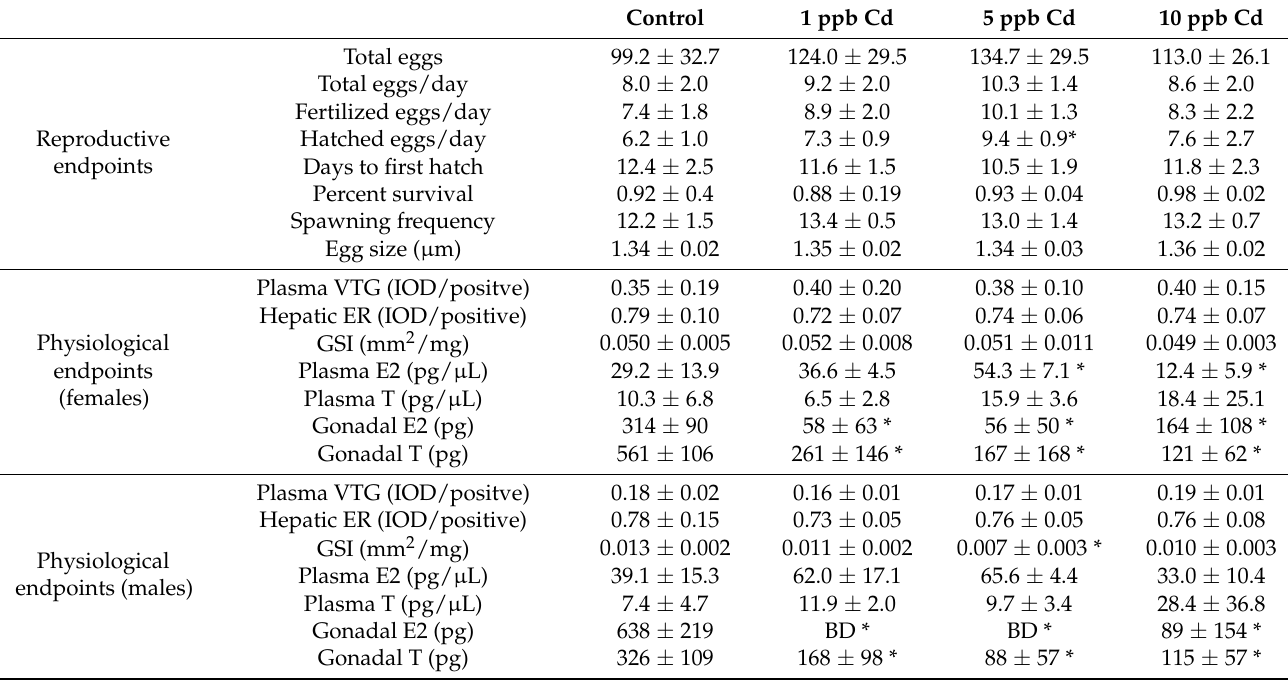
Table 1. Reproductive and physiological endpoints for adult medaka pairs exposed to Cd for 7